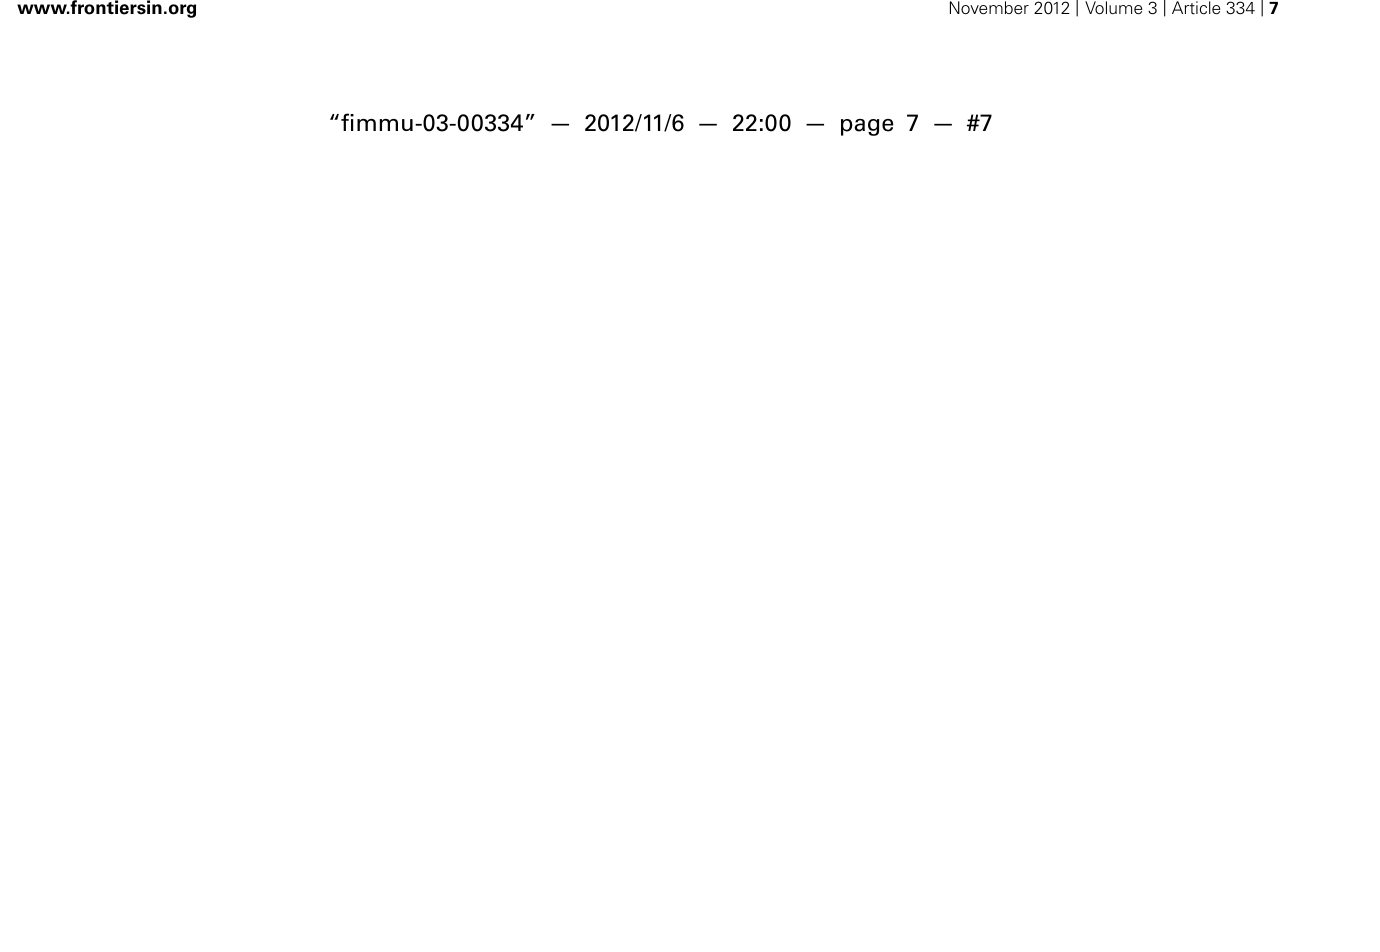
(N153) are depicted as stick representations and colored brown. (B) Side view of the E protein dimer with all colorations the same as in panel A. (C) Close up of the EDII FP from one monomer and EDIII region of the other at the dimer interface, as it appears in panel B.The side chains of two residues in the EDII FP and three residues in EDIII where CRR substitutions were introduced are depicted as ball and stick representations and labeled with the introduced substitutions. Structural domains are colored as in panel A and the two antigenic regions EDII FP and EDIII CR are noted with circles roughly representing the size of an IgG footprint binding to these